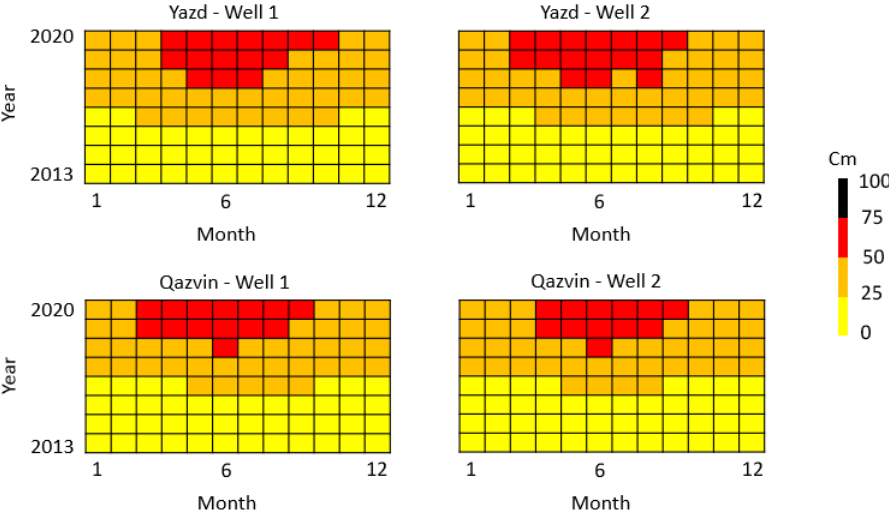
Figure 13. Heatmap plot of difference between monthly average of predicted groundwater level depth from 2013 to 2020 and base period . Table 8. Correlation coefficient between changes in groundwater level and meteorological parame- ters. Green color refers to p -Value smaller than 0.05 and red color shows p -Value greater than 0.05 .